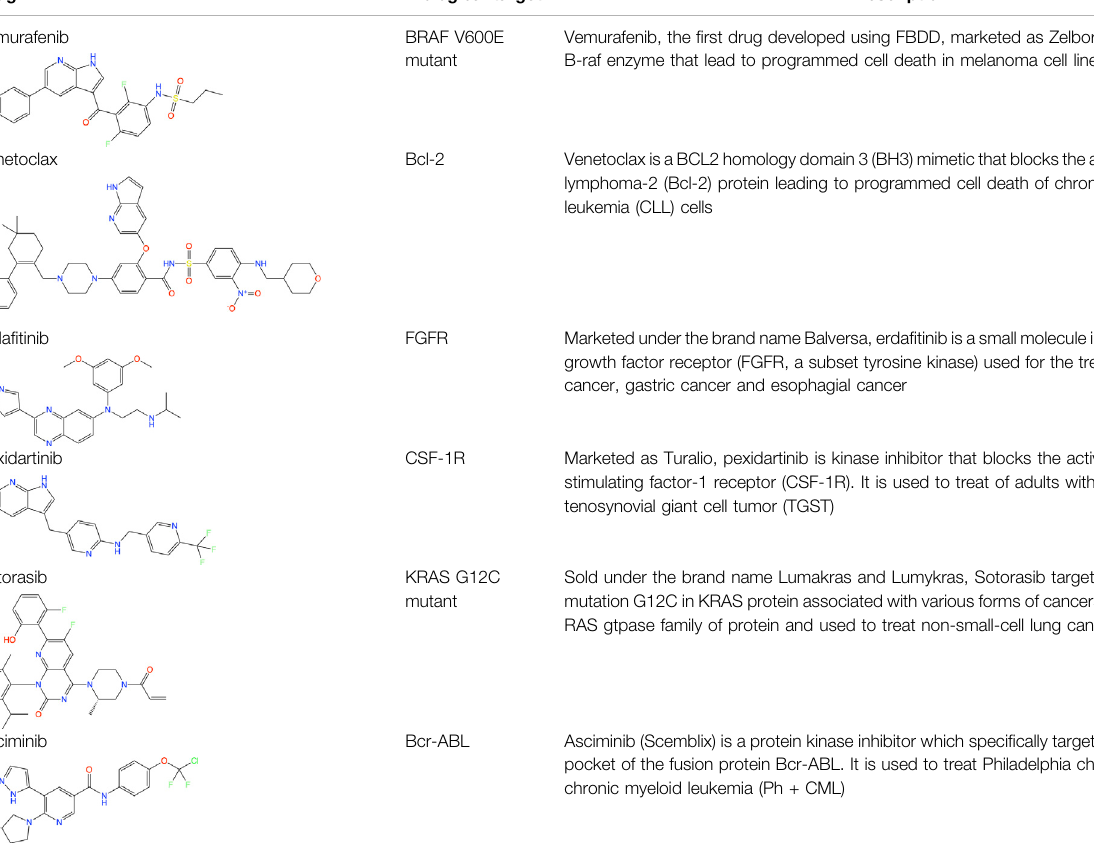
TABLE 1 | Drugs on the market developed by FBDD approach and their biological targets.